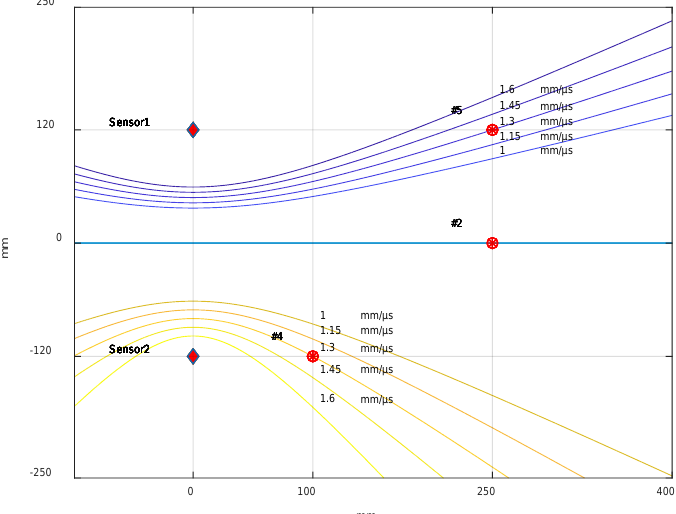
Figure 14. Graphical results derived from Equation (4) with an average velocity of 1.3 mm/ µ s and its variation in the range of ± 0.3 mm/ µ s. At symmetric impact point #2, the curves are overlapped for all velocities, showing independence from velocity values.